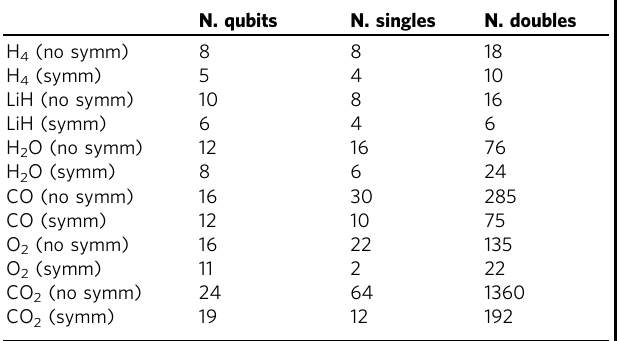
Columns represent the number of qubits in the molecular Hamiltonian, number of single excitations, and number of double excitations. All the values are provided for the minimal basis set within frozen core